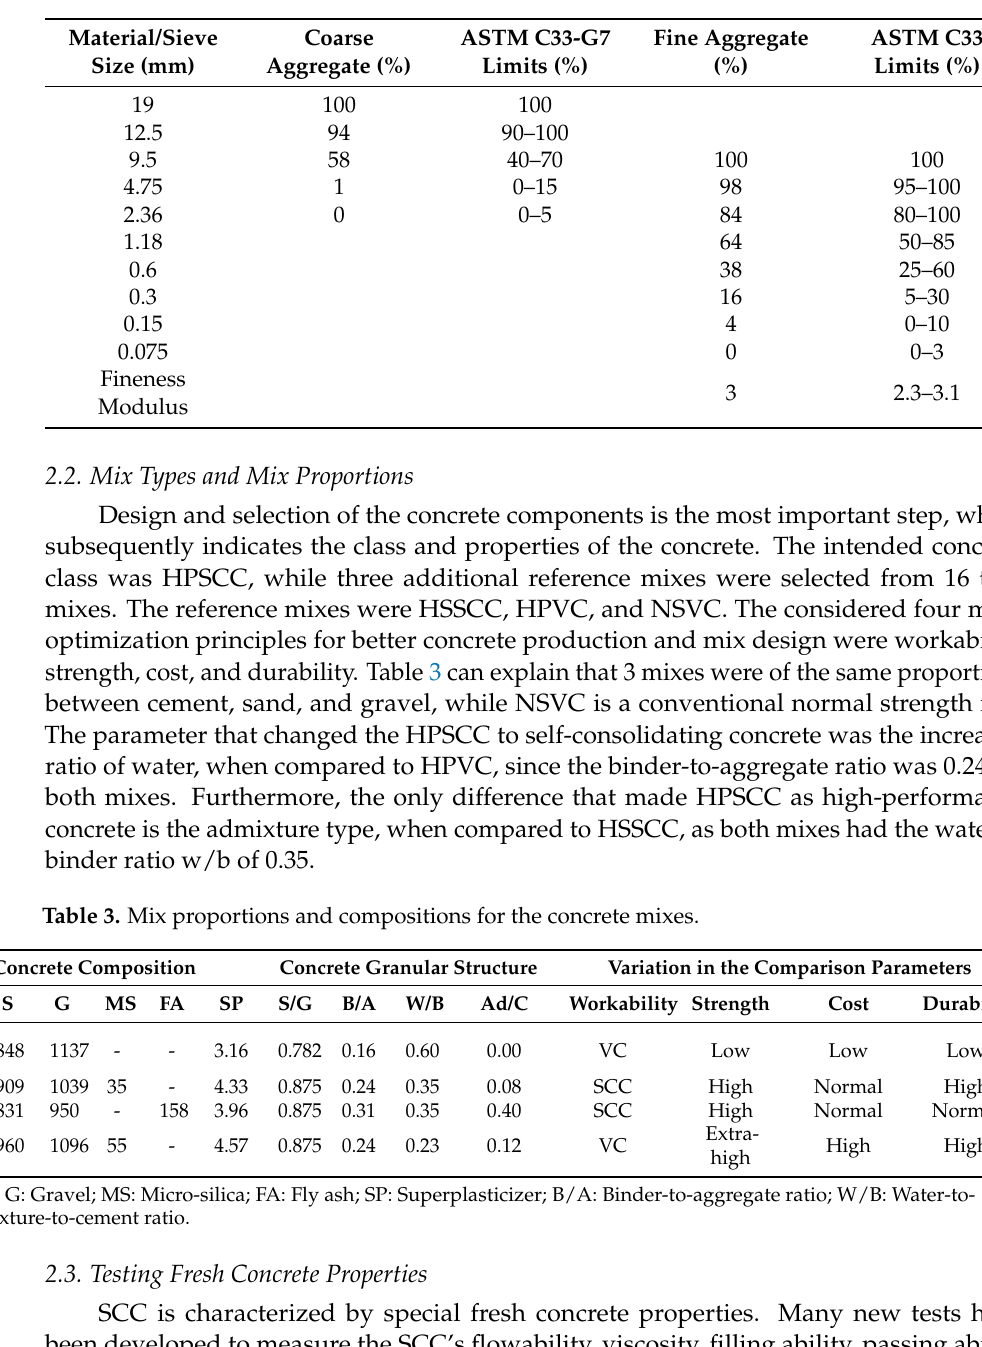
Table 2. Grading of coarse and fine aggregates.